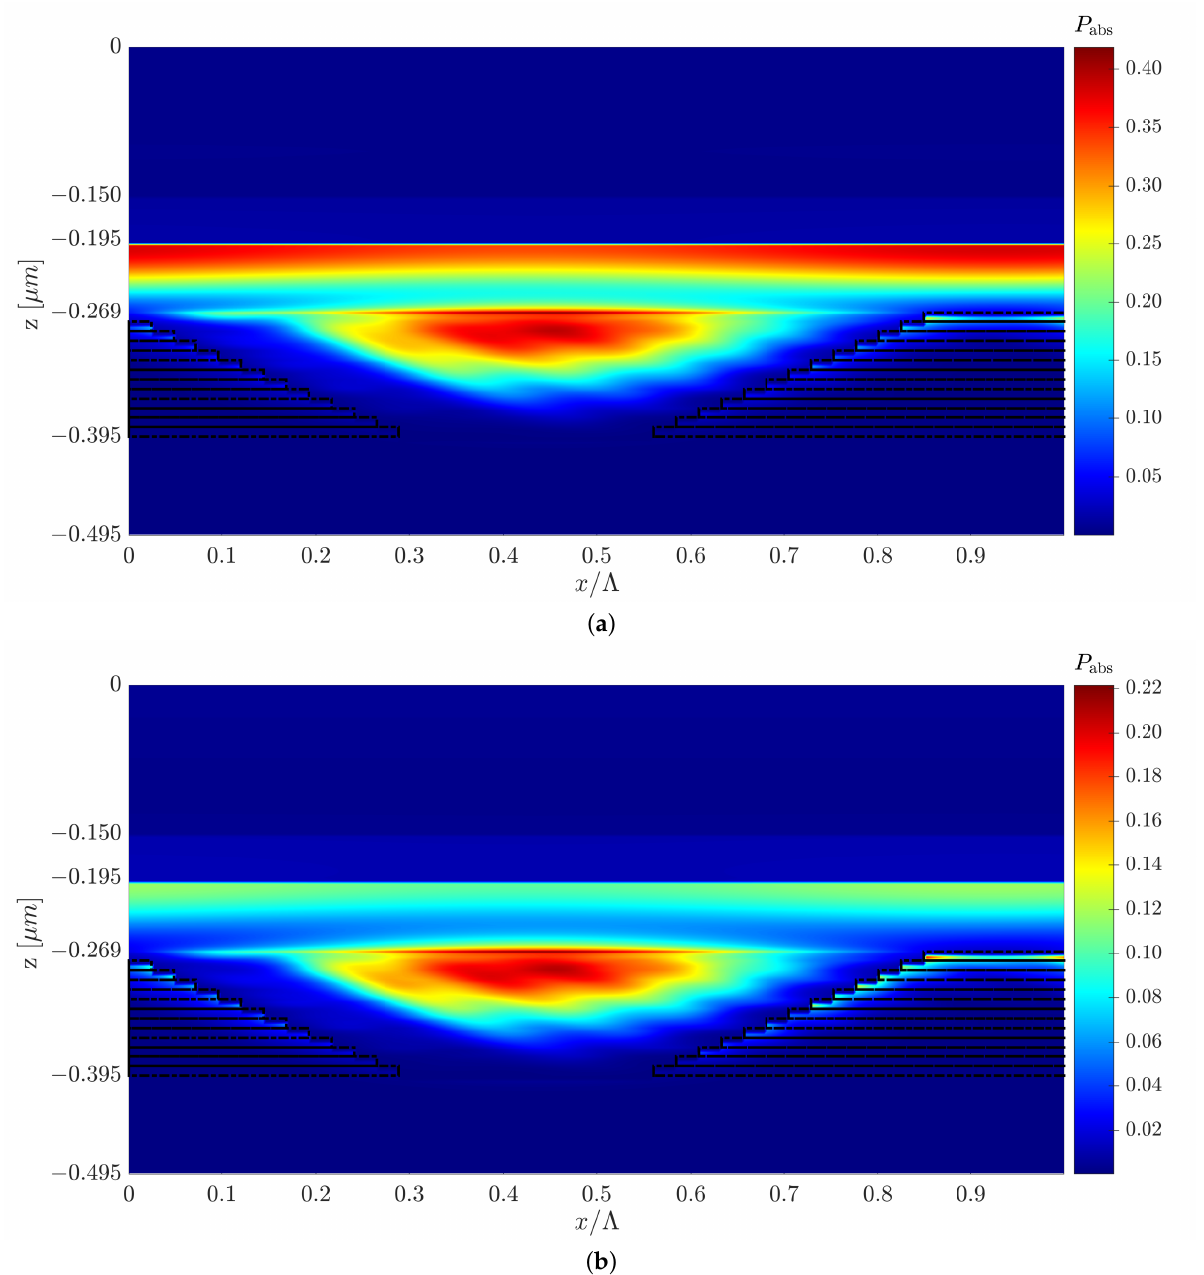
Figure 9. Normalized absorbed power profile color map of Pyramid B at ( a ) λ = 500 nm and ( b ) λ = 600 nm, where the y cross-section is at the center of the P3HT:PCBM grating